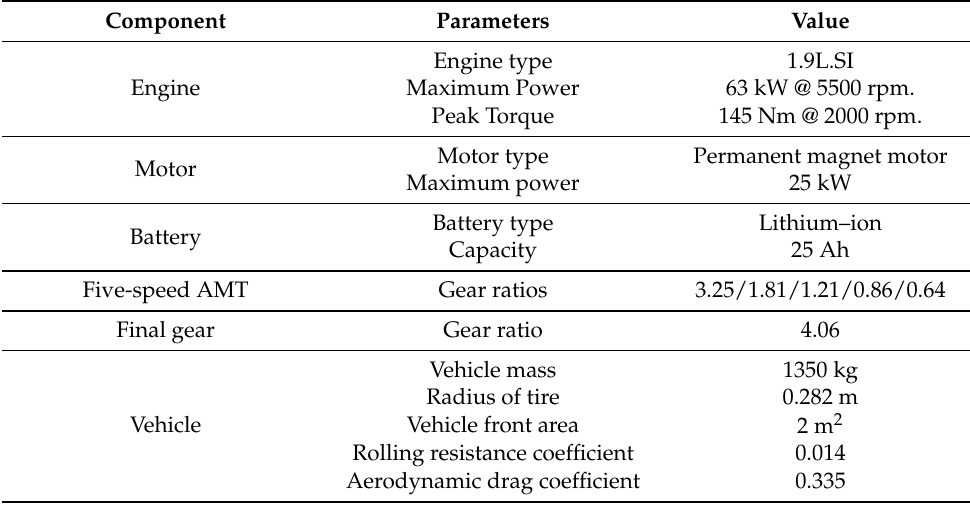
Figure 1. The structure of the hybrid powertrain. Table 1. The parameters of the